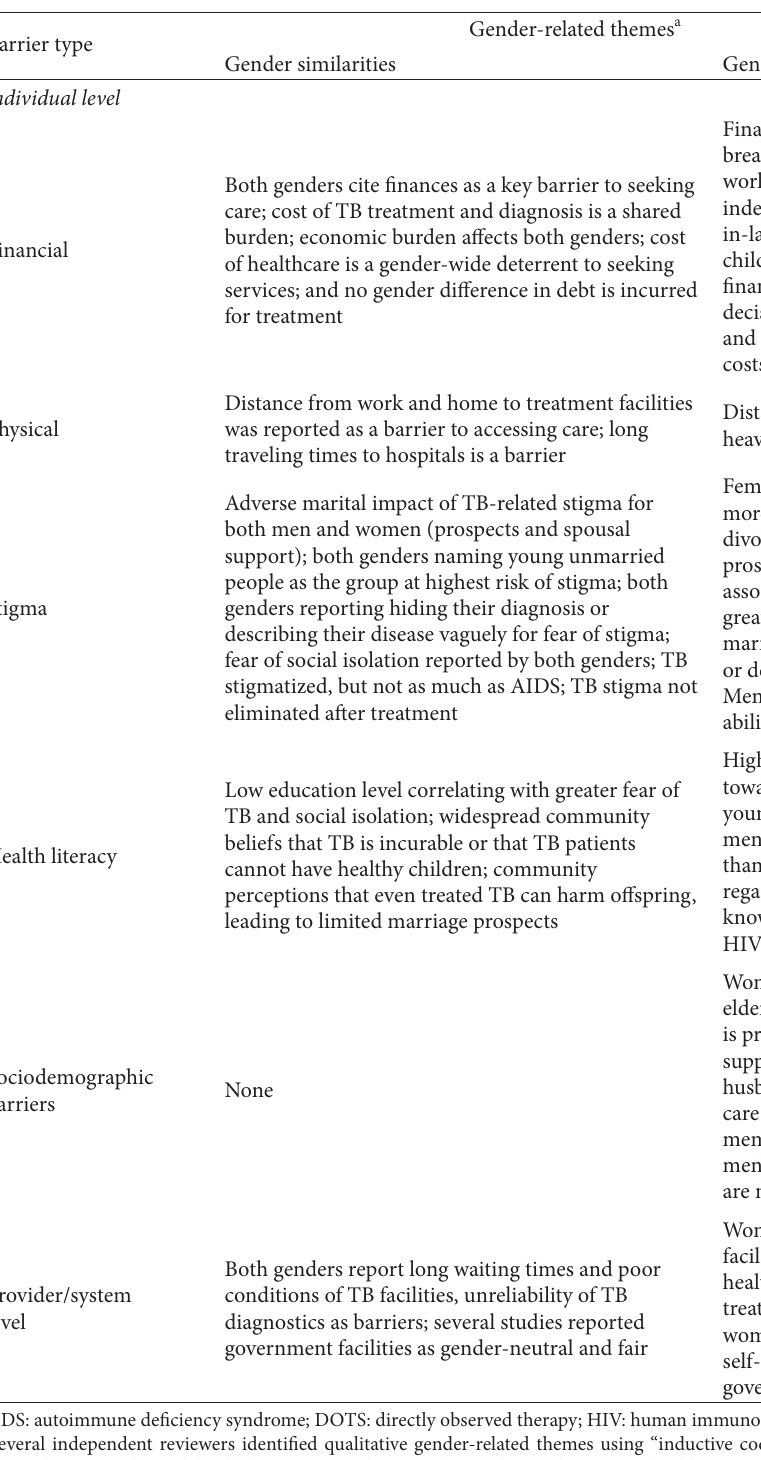
Table 3: Summary of emergent gender-related themes by barrier